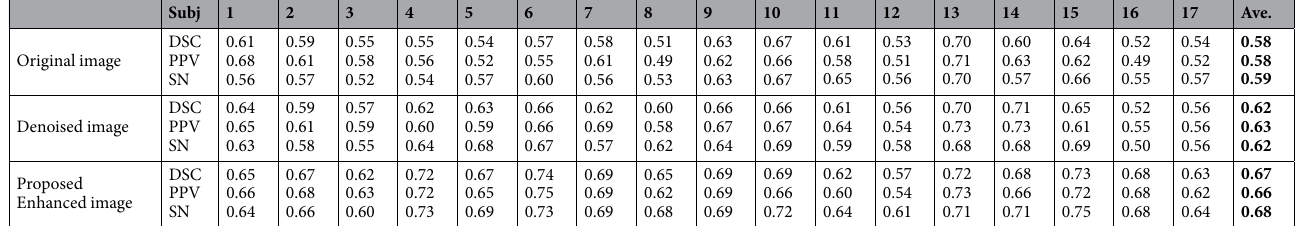
Table 1. Segmentation accuracy of the vesselness hard-thresholding method on the original 7 T MR images, the denoised images, and our enhanced and denoised images.